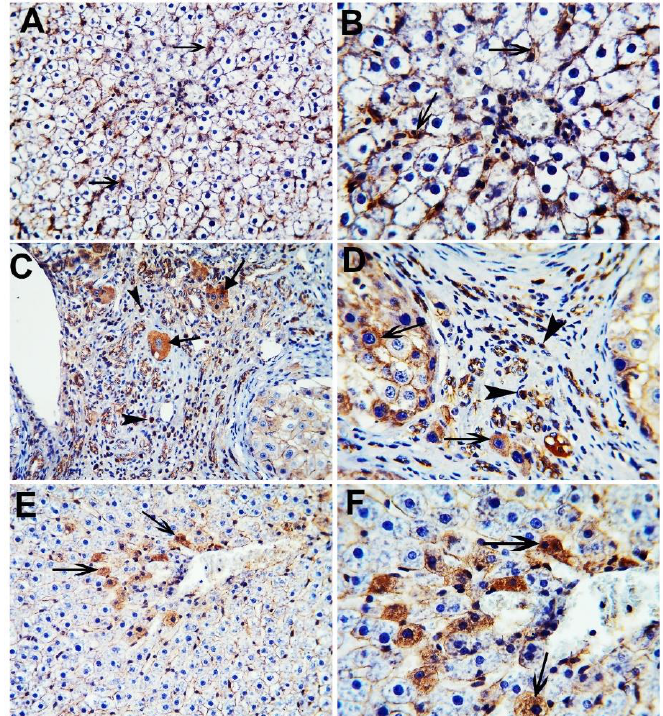
Figure 7. Immunohistochemical stained liver sections of β -catenin. Control group ( A , B ); HCC group ( C , D ); CA group ( E , F ). Black arrowheads indicate nuclear localization of β -catenin positive cells and black arrows indicate cytoplasmic localization of β -catenin positive cells. X 200 ( A , C , E ), X 400 ( B , D , F ).